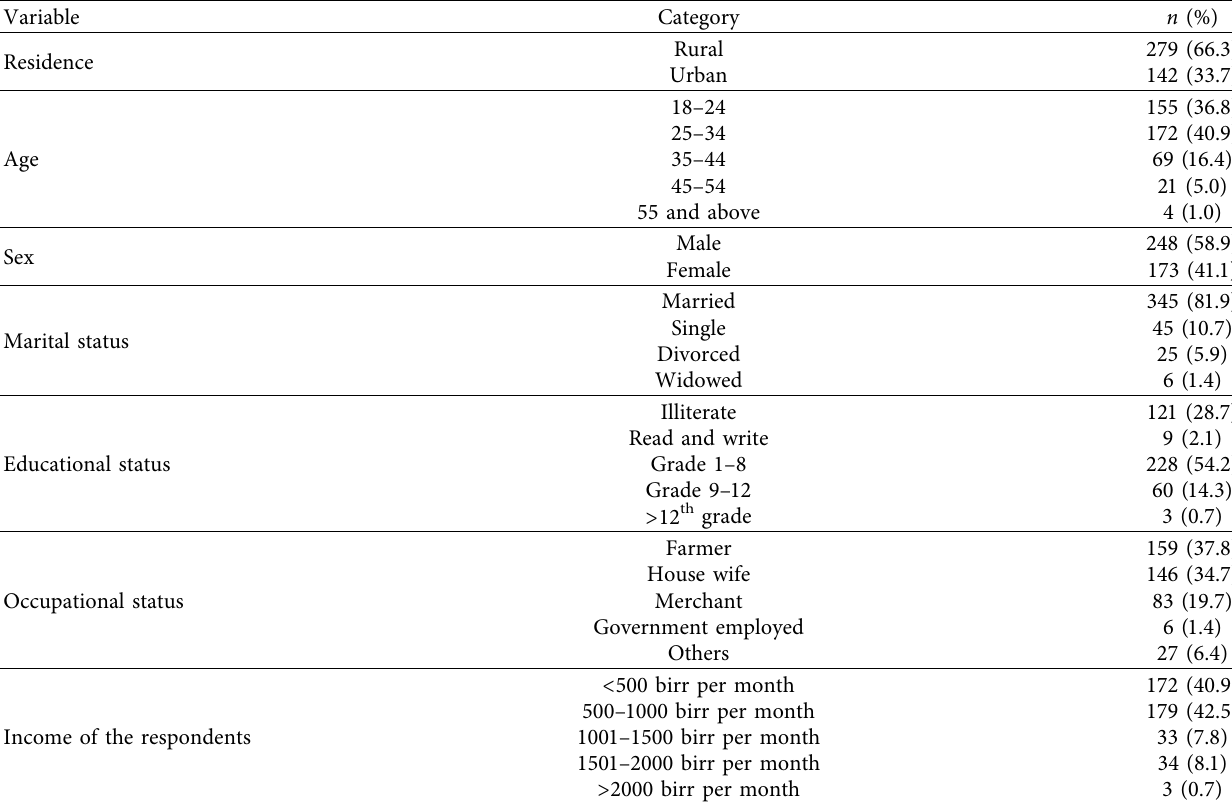
Table 1: Socio-demographic characteristics of the study participants, Halaba town, Southern Ethiopia, 2017.